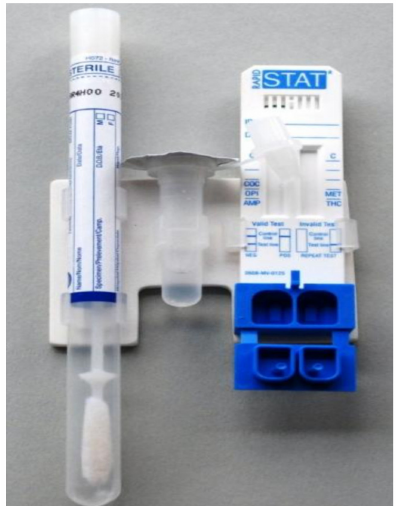
Figure 6. Mavand Rapid STAT ® saliva multi-drug test system (reproduced with permission from Elsevier